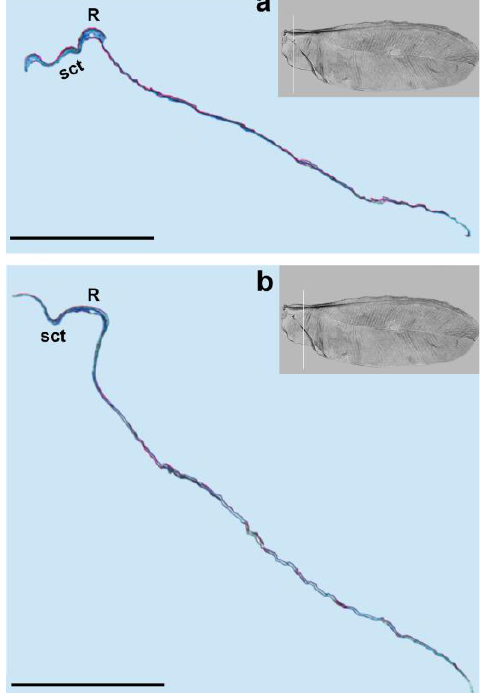
Figure 3. Cross-section of the wing of M. pini . Scale bar 100 µ m, ( a , b ) median fold in black dotted circle.